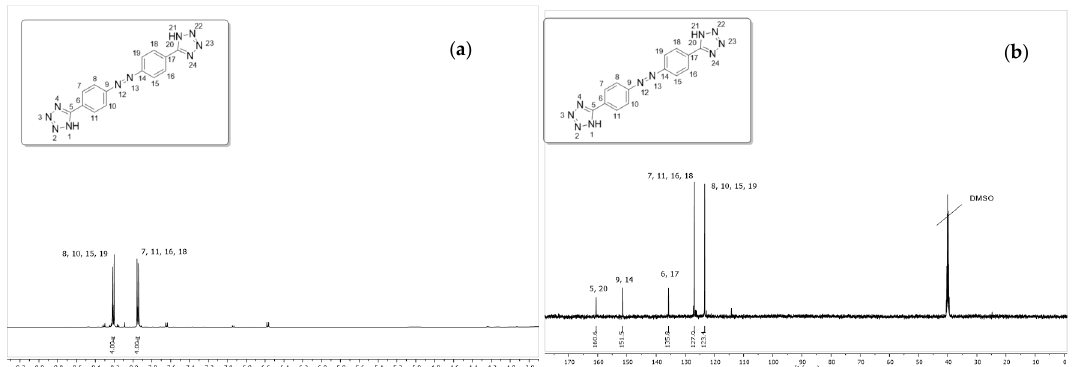
Figure 3. ( a ) 1 H NMR spectrum of the bis -tetrazole 3 . ( b ) 13 C NMR spectrum of the bis -tetrazole 3 .